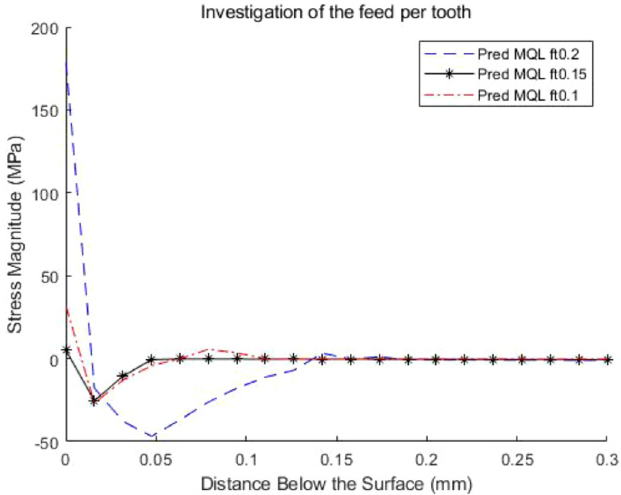
Fig. 10. Investigation of the residual stress under MQL with cutting velocity 1600 m/min, depth of cut 0.5mm at different feed per tooth.